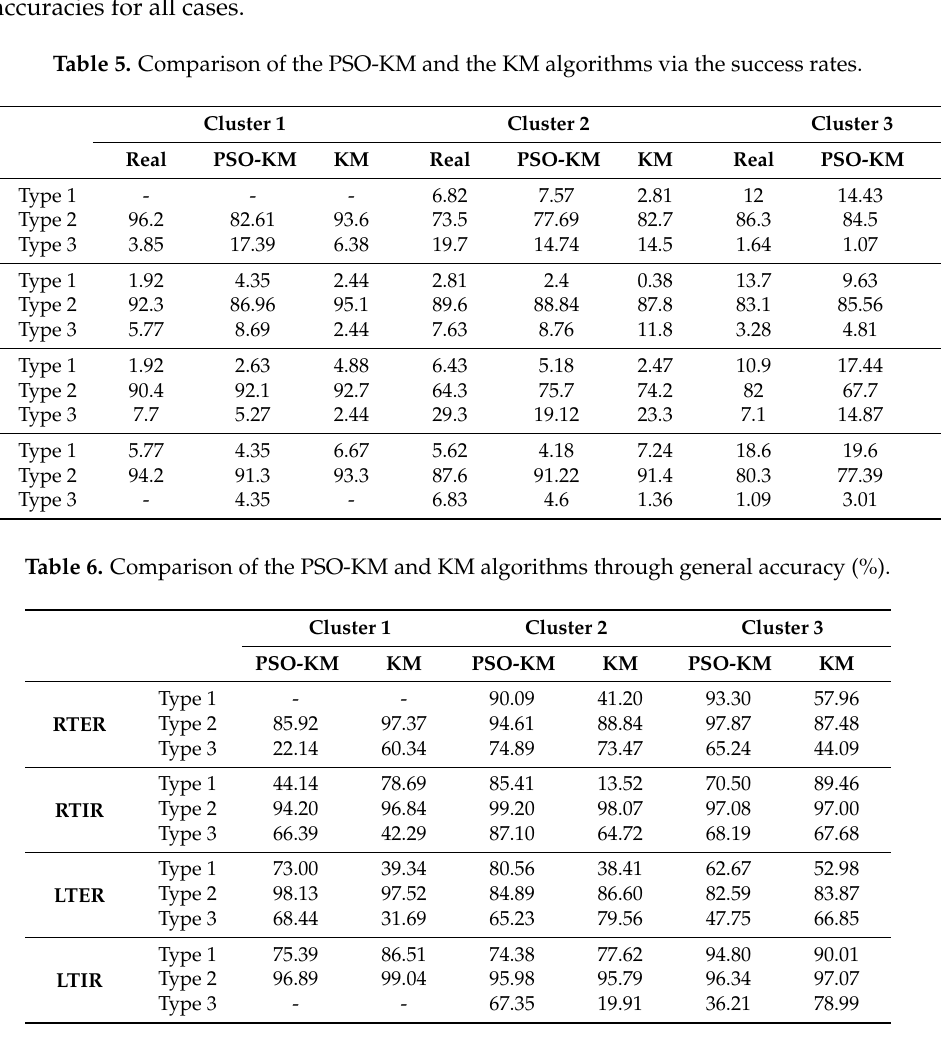
Table 5. Comparison of the PSO-KM and the KM algorithms via the success rates.